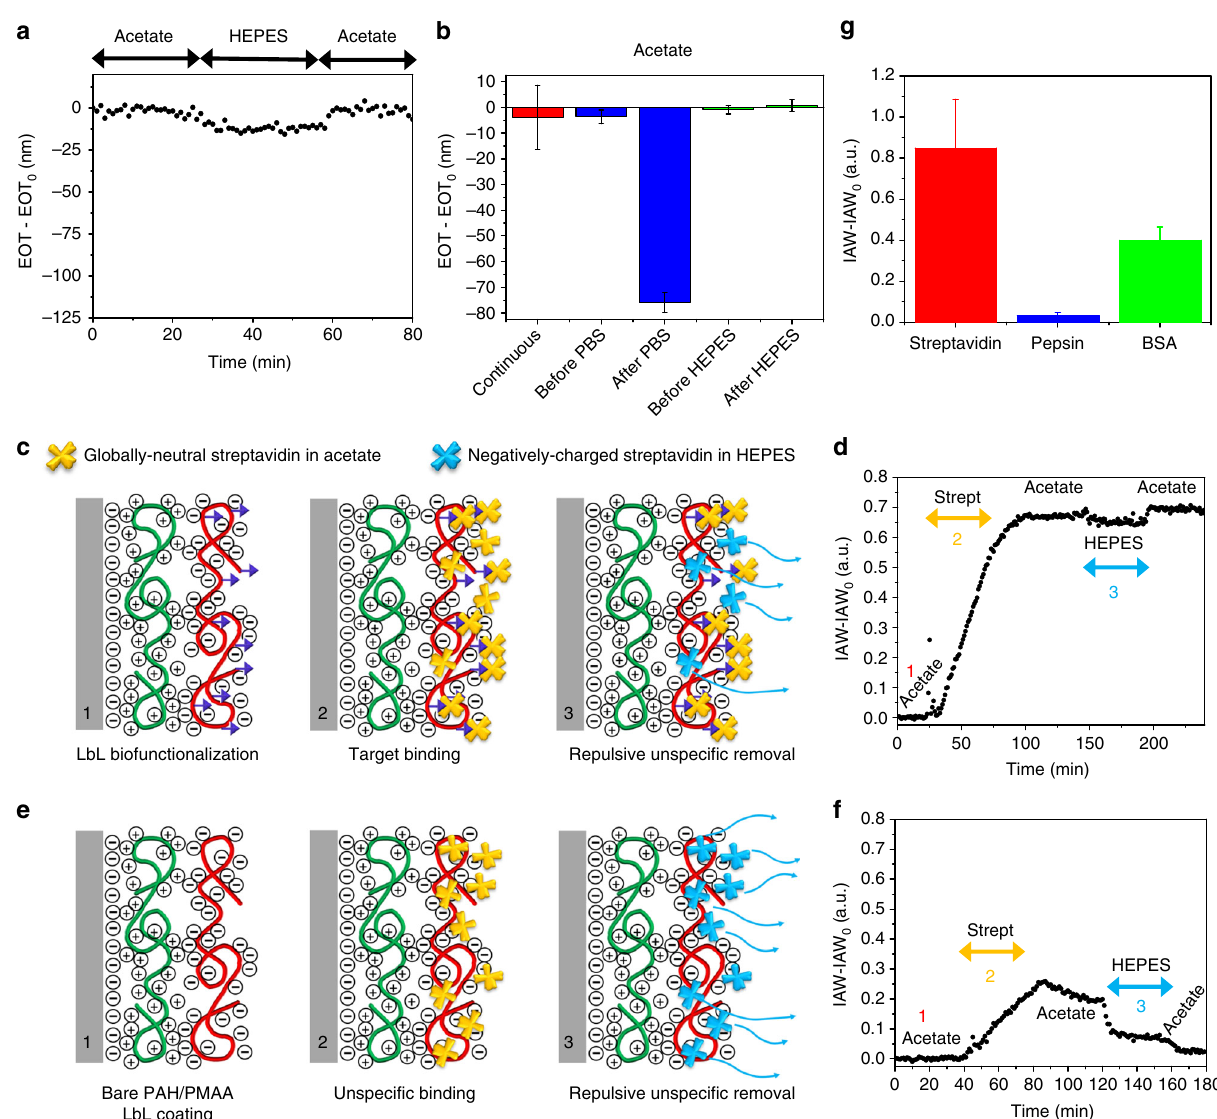
Fig. 3 Stability and speci fi city of LbL biofunctionalization. a Sensorgram (EOT-EOT 0 vs. time) recorded on LbL-biofunctionalized PSi interferometers highlighting high stability of the LbL nano-assembly both in acetate and HEPES buffers. b EOT-EOT 0 values acquired on LbL-biofunctionalized PSi interferometers upon continuous in fi ltration of acetate buffer, as well as in acetate buffer before and after injection of PBS and HEPES buffers. Data are provided as average values of EOT-EOT 0 fl uctuations over time (data points >30) with error bars representing one standard deviation. c Sketch of the inner surface of PSi interferometers LbL-biofunctionalized with PAH/b-PMAA (1), highlighting af fi nity (speci fi c) binding of streptavidin with biotin (2) and repulsive rinsing of streptavidin unspeci fi cally adsorbed (electrostatic interaction) on b-PMAA (3). d Sensorgram (IAW-IAW 0 vs. time) acquired on LbL- biofunctionalized PSi interferometers upon injection of streptavidin 8.3 µ M: signal stabilization in acetate buffer (step 1); injection of streptavidin and af fi nity interaction of streptavidin with b-PMAA (step 2); repulsive rinsing in HEPES buffer and removal of streptavidin unspeci fi cally adsorbed on b-PMAA (step 3). Acetate buffer is eventually injected to allow a direct comparison of the IAW values before streptavidin injection and after repulsive rinsing to be feasible. e Sketch of the inner surface of PSi interferometers LbL-coated with bare PAH/PMAA (non-biotinylated) (1), showing unspeci fi c interaction of streptavidin with PMAA (2) and complete removal of streptavidin unspeci fi cally adsorbed on PMAA by repulsive rinsing (3). f Sensorgram (IAW-IAW 0 vs. time) acquired on PSi interferometers LbL-coated with bare PAH/PMAA (non-biotinylated) upon injection of streptavidin 8.3 µ M (steps 1 through 3 as in d ). g IAW-IAW 0 values measured on LbL-biofunctionalized PSi interferometers upon injection of 8.3 µ M streptavidin (target molecule), as well as 14 µ M Pepsin and 7.6 µ M BSA (non-target molecules), highlighting that a high speci fi city is achieved through repulsive rinsing. Data are provided as average values over 3 replicates with error bars representing one standard